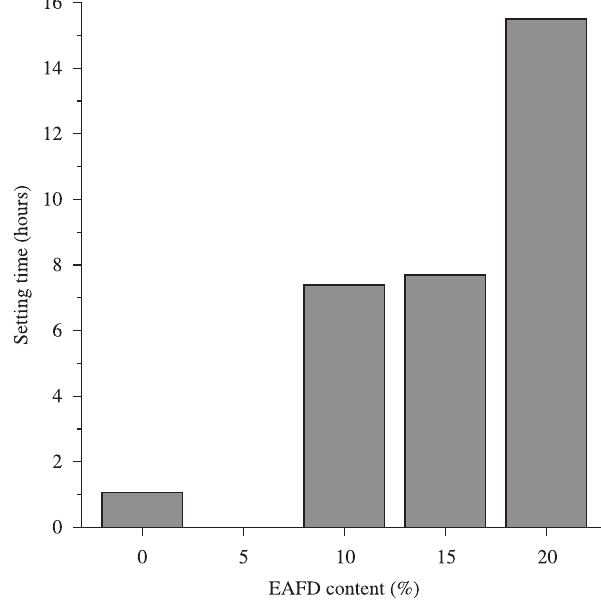
Figure 8. Effect of the EAFD content on the cement setting time. Figure 7. Concrete sample diametral strength after 28